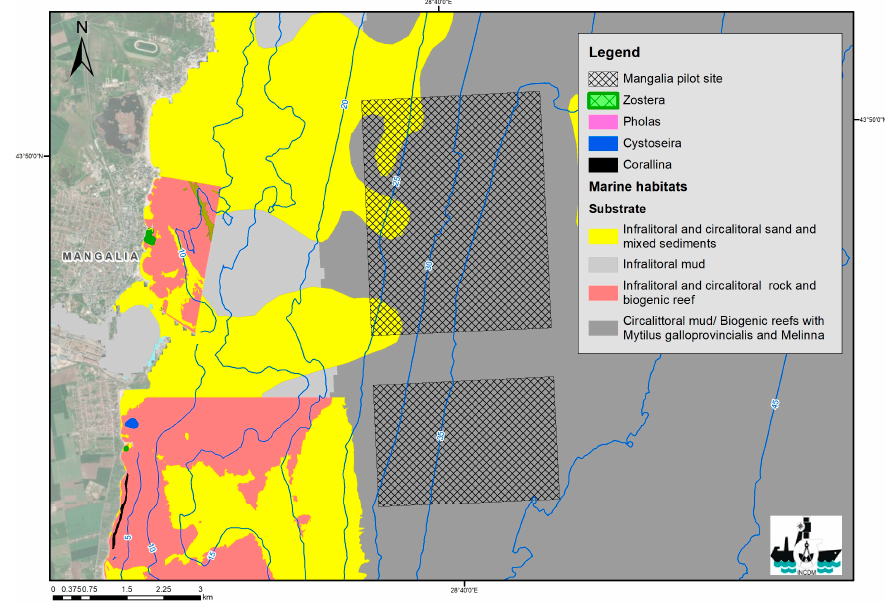
Figure 7. Habitat map in the Mangalia polygon .